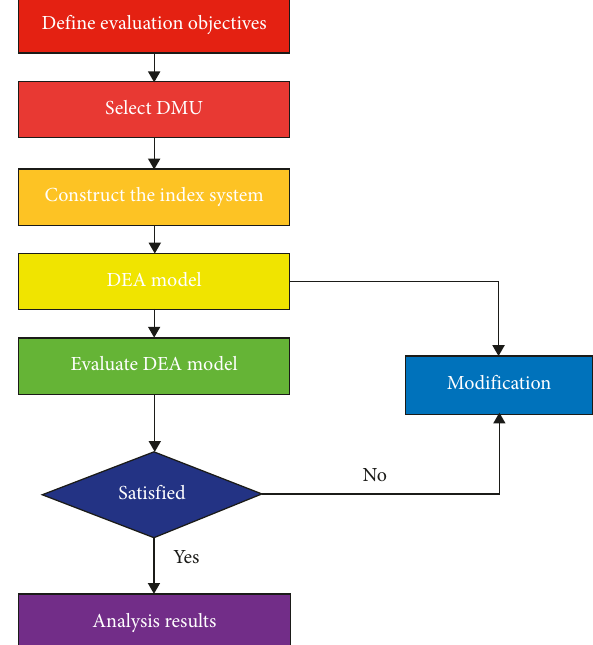
Figure 1: DEA model construction